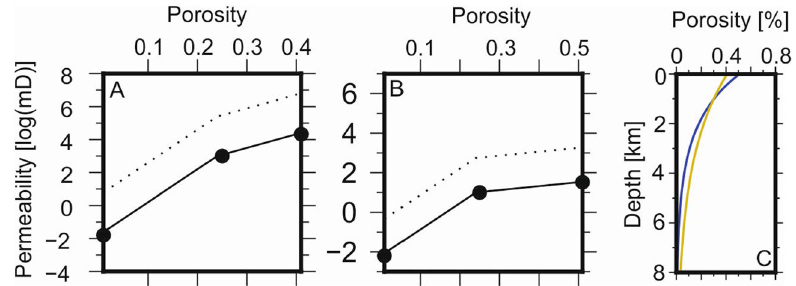
Figure 8. Upscaled rock permeability and porosity. Values from Table 2 (black circles) are used to calculate rock permeability between maximum (depositional) porosity and zero 7 . A = sandstone, B = carbonate. Solid and dotted lines represent vertical and horizontal permeability, respectively. C = porosity-depth relationship calculated using Athy’s relation 48 . Gold and blue lines represent sandstone and carbonate,